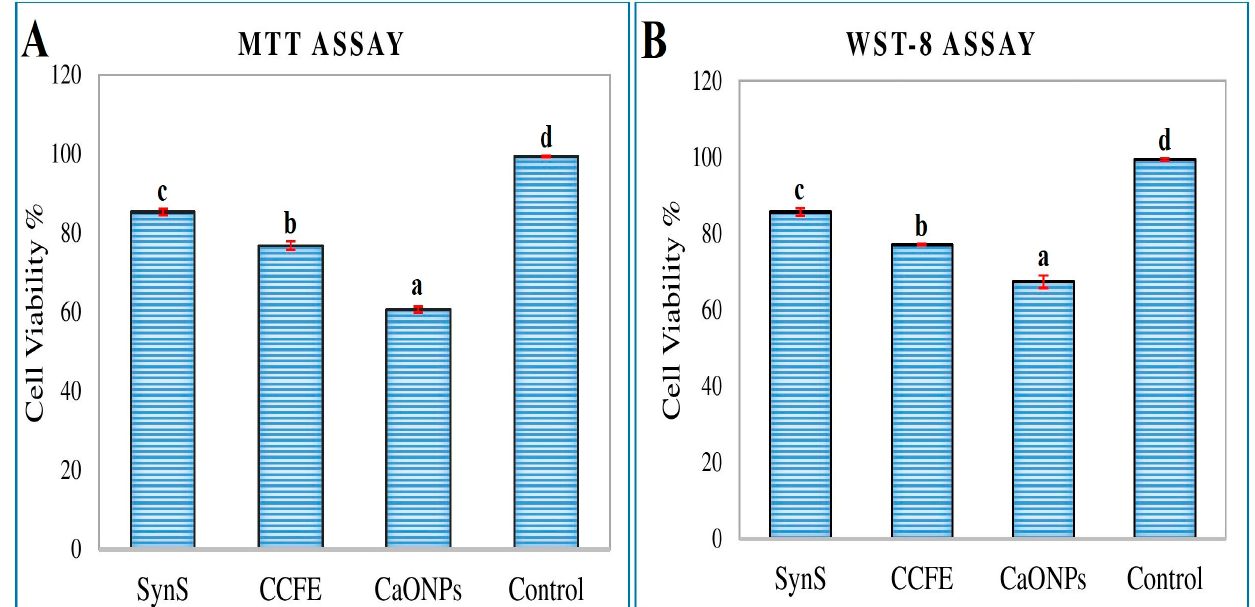
Figure 7. Cell viability percentages of CaONPs, C. colocynthis fruit extracts, and their synergistic solution by MTT assay ( A ) and WST-8 assay ( B ). SynS—a synergistic solution of calcium oxide nanoparticles and C. colocynthis fruit extracts; CCFE— C. colocynthis fruit extracts; CaONPs—calcium oxide nanoparticles. Data are expressed as mean ± SEM. In one-way ANOVA, the values p < 0.05 were considered significant. The Duncan Multiple Range Test (DMRT) was performed for values that were significantly different. The different alphabets on the bars indicate a significant difference in group means (n = 3). The same alphabets above the bars indicate there was no significant